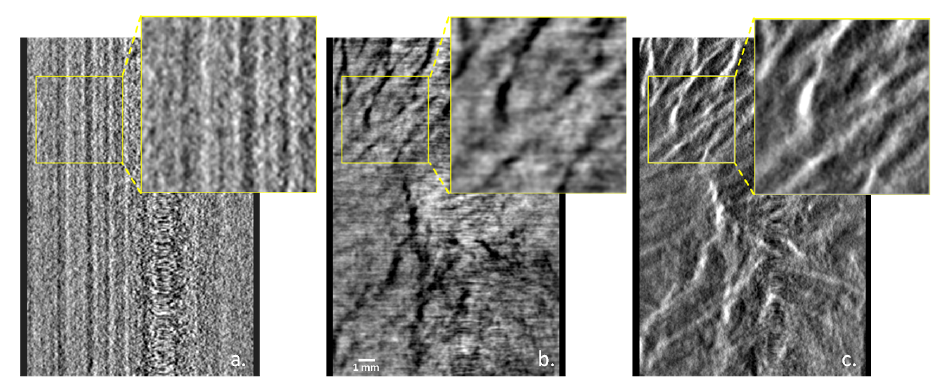
Figure 6. Grating based phase contrast tomogram slice of a cellulose foam. ( a ) shows the attenuation, ( b ) the phase contrast and ( c ) the dark field, small angle scattering,